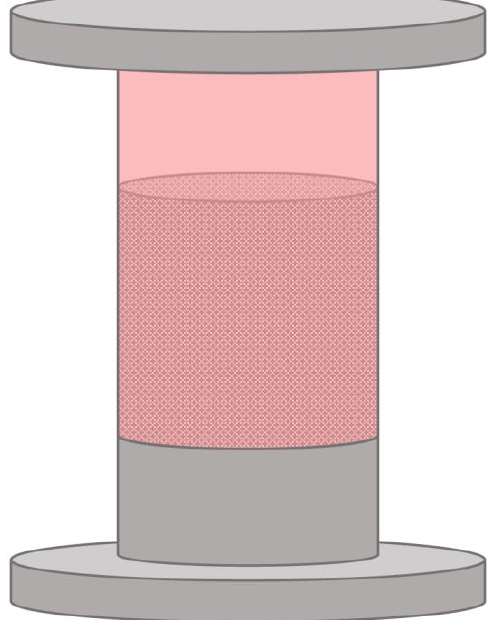
Figure 3. Schematics of a fixed-bed bioreactor.